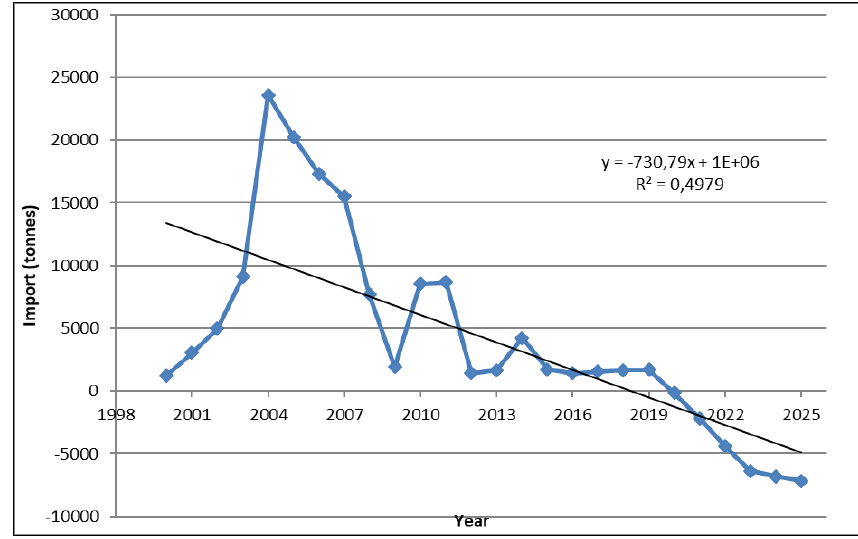
Figure 9. Turkey’s oats import (2000-2025). Source: